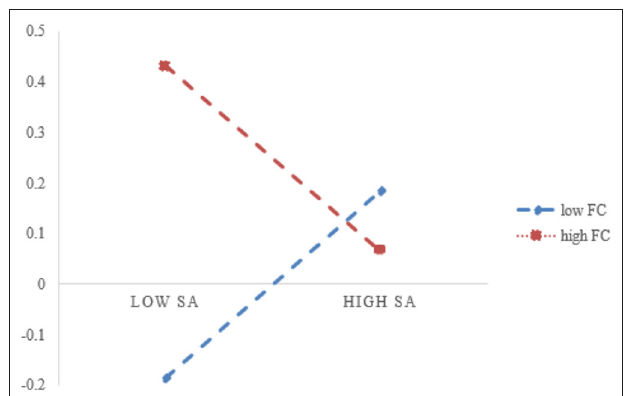
FIGURE 3 | Mediating role of financial warning